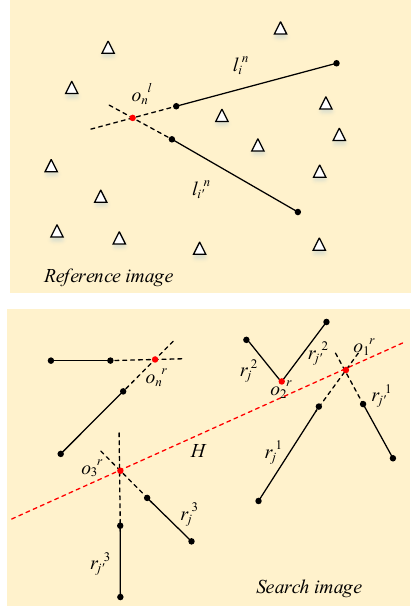
Figure 3. Epipolar constraint of the intersection point. The intersection points of the line-pairs are depicted as red dots. The triangles represent the corresponding points used